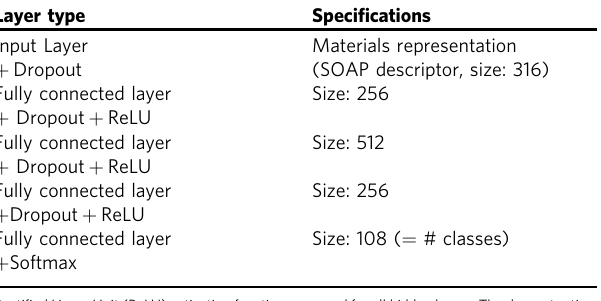
Table 1 Architecture of the fully connected Bayesian neural network used in this work.